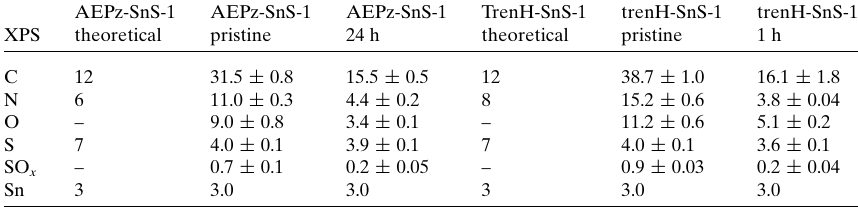
Table 1 Relative atomic concentrations as determined from high-resolution XPS spectra. The numbers are shown as referenced values, where atom ratios have been calculated relative to a fixed value of Sn = 3.0. The theoretical values are based on a pristine sample with no contaminants and with two organic amines per (Sn 3 S 72 (cid:2) ) n